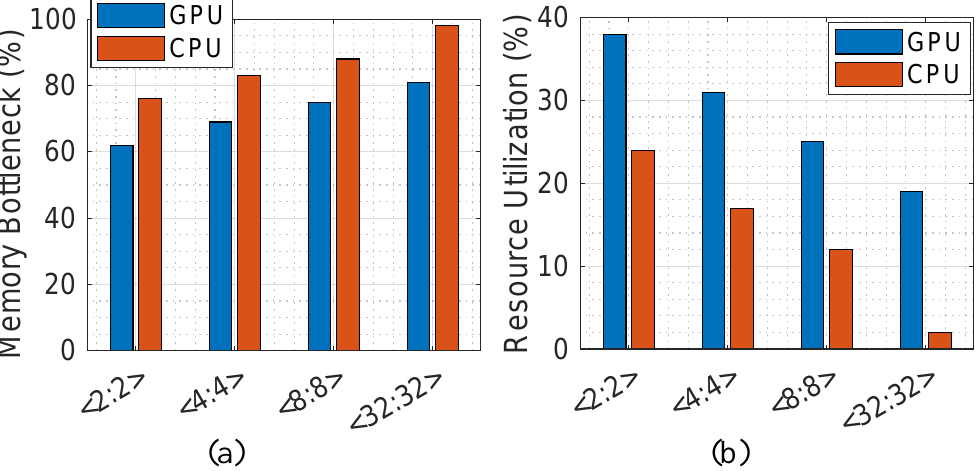
Figure 4. ( a ) The memory bottleneck ratio and ( b ) the resource utilization